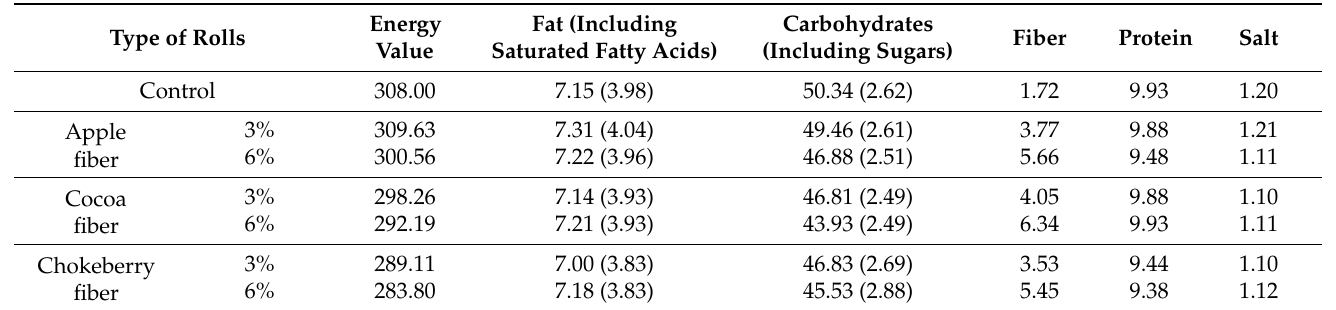
Table 7. Energy value (kcal/100 g) and nutrient and salt content of control and fruit-flavored rolls (g/100